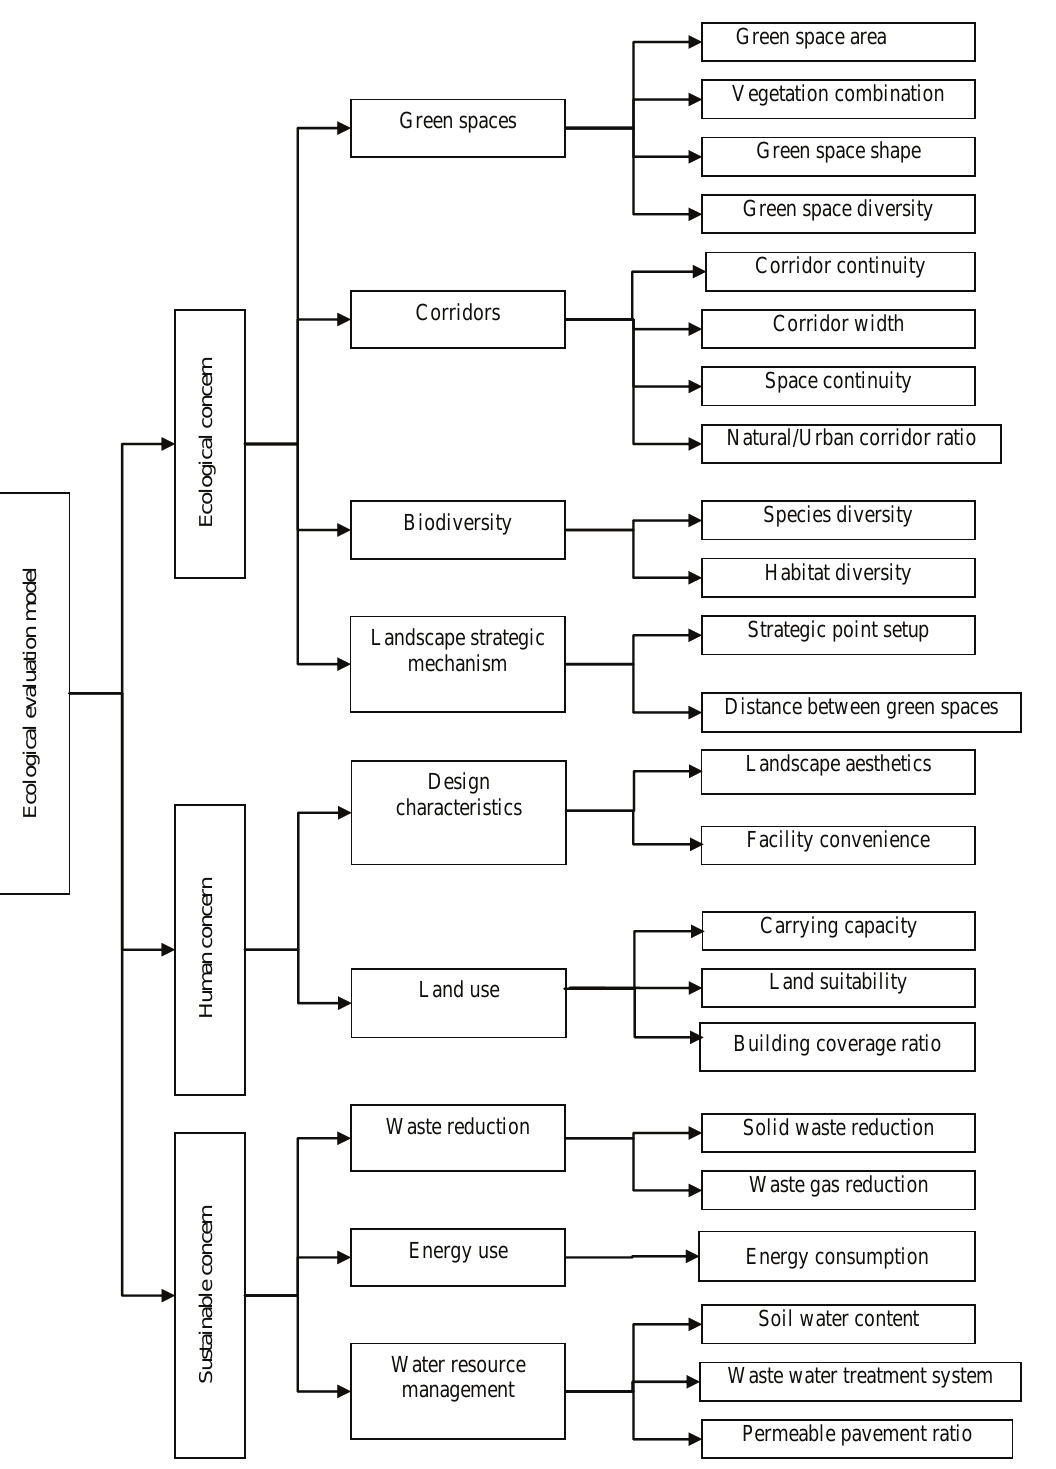
figure 1. Ecological evaluation hierarchy for urban land